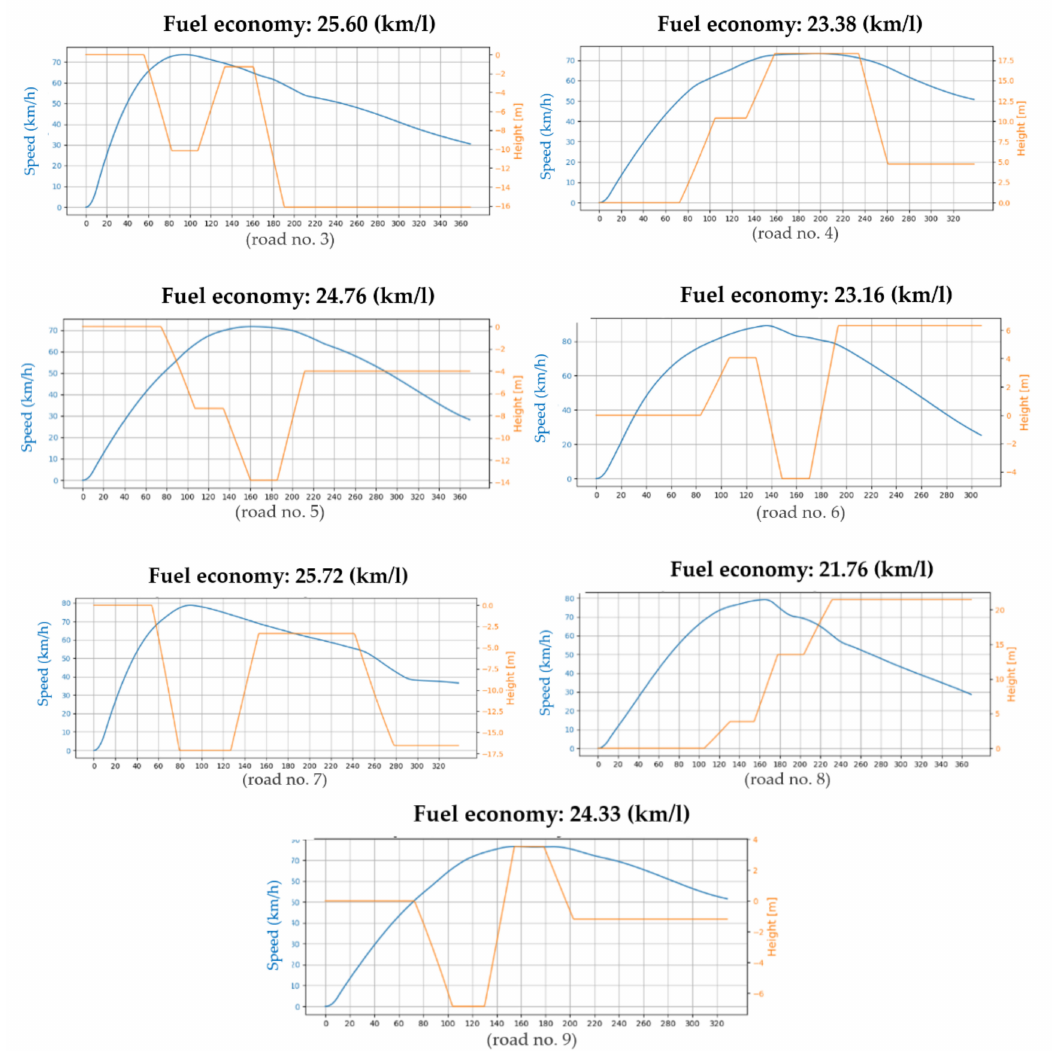
Figure A2. The final result for the nine roads, road no. 1–9, which are used in the training